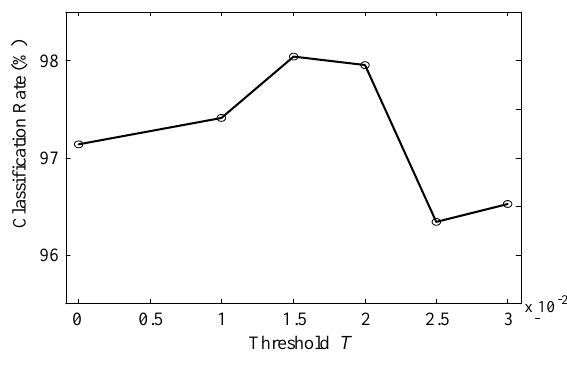
Figure 6. Classification rates for various threshold T